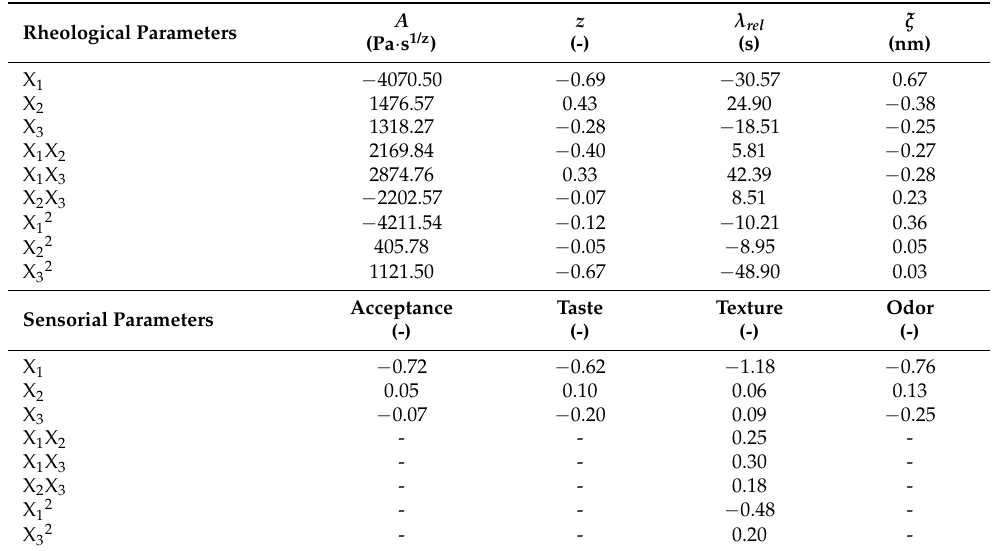
Table 3. The RSM model coefficients of different rheological and sensorial parameters of SBL- added